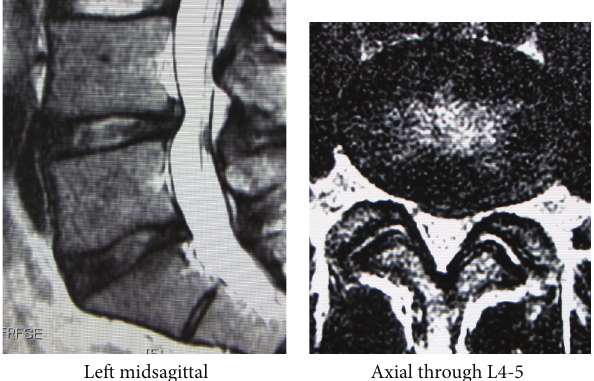
Figure3:T2-weightedMRIfindingsonthesecondvisit.Sagittaland axial images both show that the size of the disc protrusion is similar to that in the first MRI. This time, however, the HIZ is